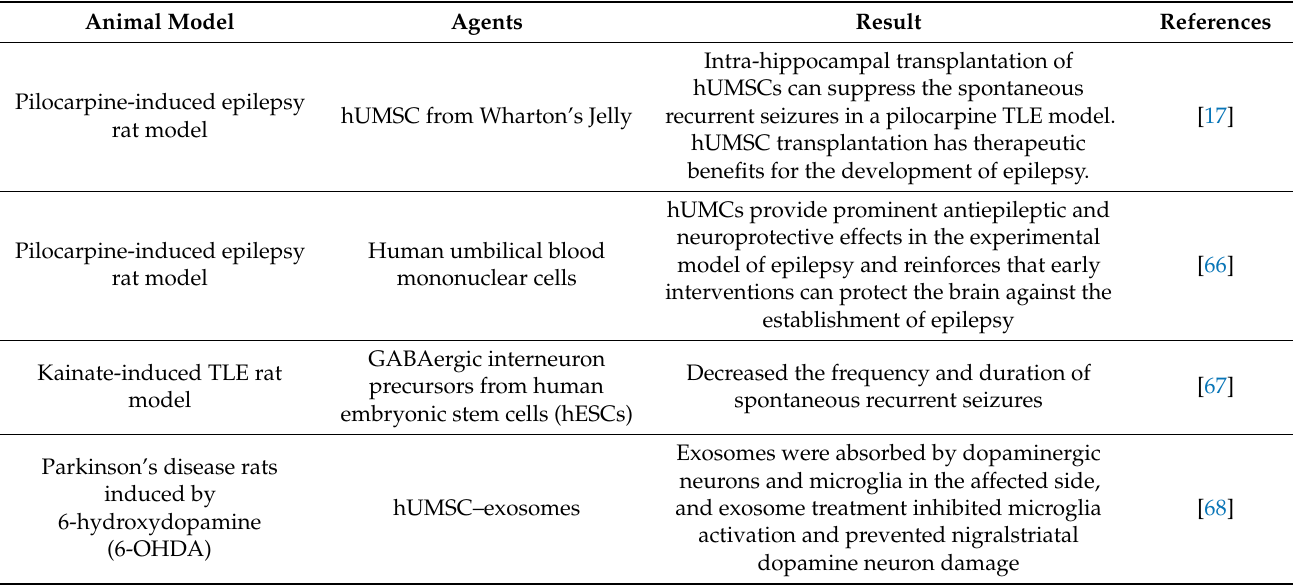
Table 1. Preclinical evidence of hUMSCs and hUMSC–exosomes in epilepsy and a Parkinson’s disease animal model.